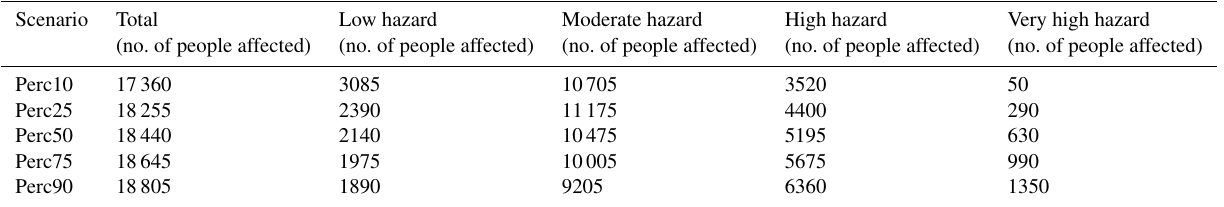
Table 4. Population potentially affected by the different flooding scenarios and their distribution on the zones with different levels of risk. The total is estimated summing the population of the low, moderate, high and very high risk